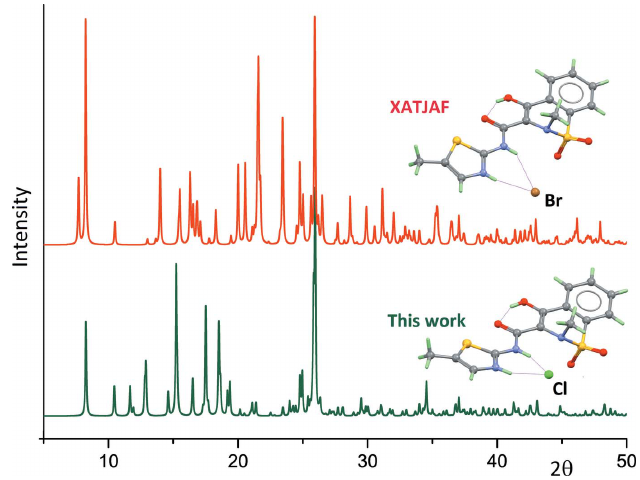
Figure 2 Simulated powder X-ray diffraction patterns for MX (cid:2) HBr (top, pattern calculated using the deposited Cif file for XATJAF; Tumanov et al. , 2011) and MX (cid:2) HCl (bottom). Patterns were calculated with Mercury (Macrae et al. , 2020), assuming the Cu K (cid:2) radiation. Molecular structures are represented along with their patterns.